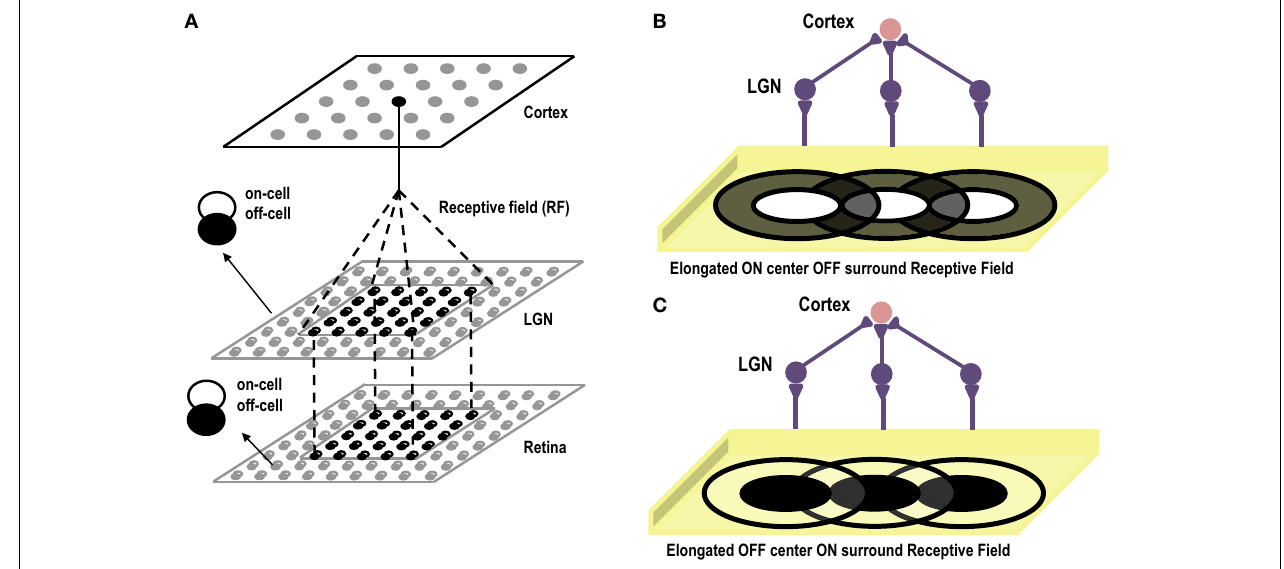
FIGURE 4 | (A) Shows the three layer abstract feed-forward model of Orientation Selectivity. The first layer, retina, is the layer that receives inputs. The second layer is the LGN. There is one-to-one mapping between retina and LGN cells. The third layer is the cortex. Many LGN ON/OFF center cells